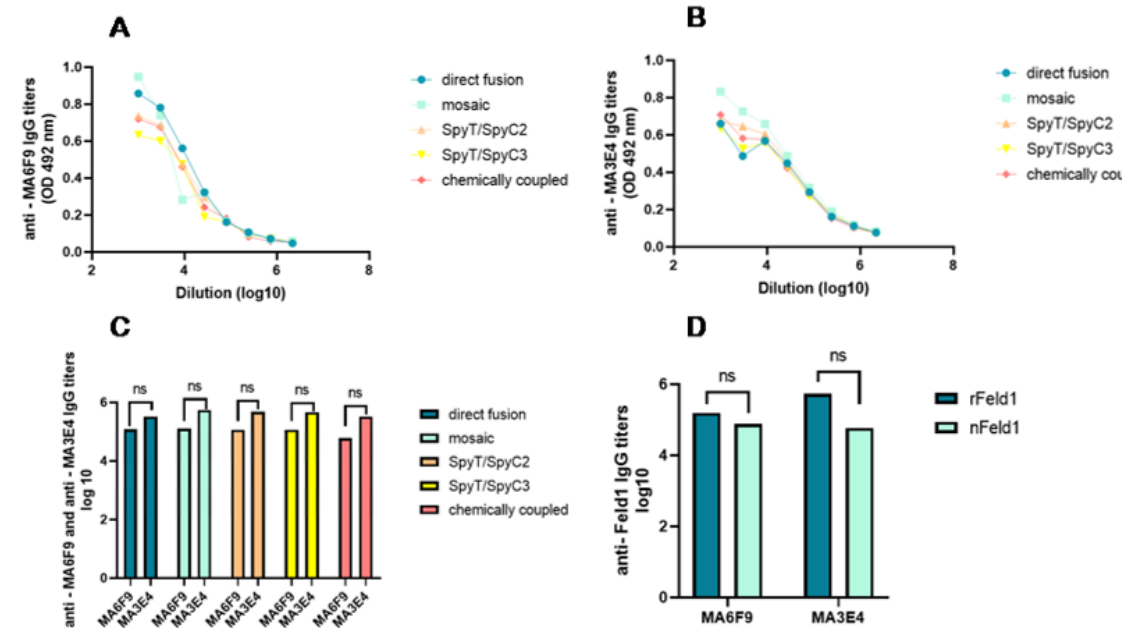
Figure 6. Monoclonal Fel d 1 antibody reaction with displayed Fel d 1 on the surface of vaccine variants. Plates were coated with 10 µg/mL of each VLP. ( A )—total IgG titers against Fel d 1 monoclonal antibody MA-6F9 (Indoor Biotechnology, USA); ( B )—total IgG titers against Feld1 monoclonal antibody MA-3E4 (Indoor Biotechnology, USA); ( C )—comparison of MA-6F9 and MA-3E4 titers of total IgGs against; ( D )—comparison of monoclonal antibody MA-6F9 and MA-3E4 titers against recombinant Fel d 1 (rFel d 1) or native Fel d 1 (nFel d 1). ( C , D )—Statistical analysis using Student’s t test in GraphPad Prism 9.0. Vaccine groups n = 5. One representative experiment was performed. A value of p > 0.05 was considered statistically significant (ns – not significant).